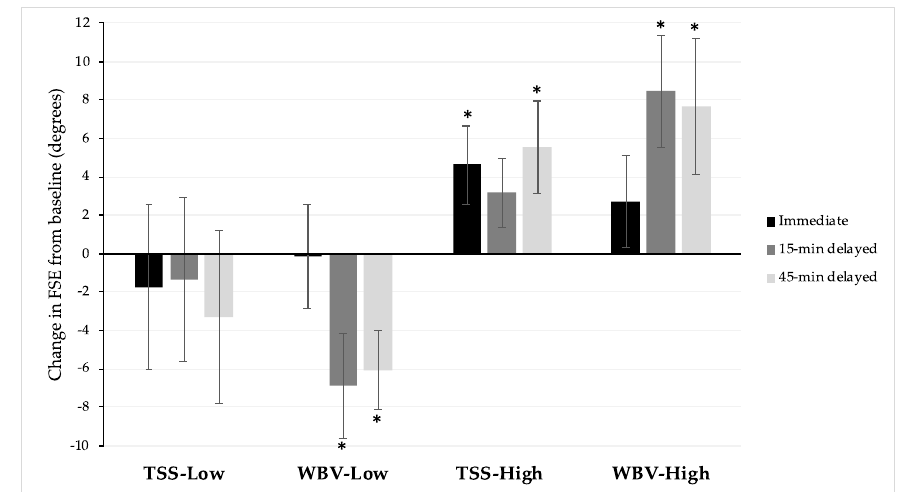
Figure 1. Mean change in FSE from baseline by subgroup. TSS, Transcutaneous spinal stimulation; WBV, whole-body vibration. Immediate (black bars), 15-min post-intervention (dark grey bars), and 45-min post-intervention (light grey bars) results are presented for participants with high (baseline FSE < 46.6°) and low (baseline FSE > 46.6°) spasticity. Asterisks (*) denote a significant ( p < 0.05) change from baseline FSE.